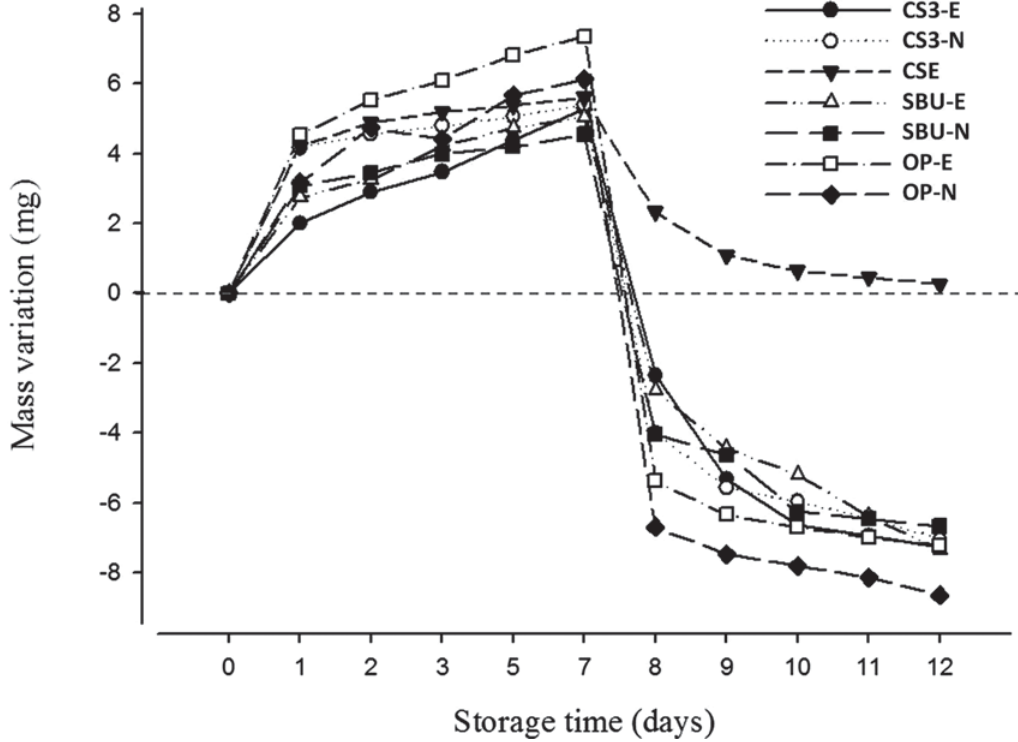
Figure 2- Changes in mass of the adhesive systems tested in the water sorption/solubility test. Symbols represent mean Y(cid:5)(cid:3)(cid:18)(cid:4)(cid:23)(cid:8)(cid:15)Z#$&(cid:16)(cid:26)(cid:8)(cid:9)(cid:25)(cid:5)(cid:13)(cid:14)(cid:5)(cid:6)(cid:14)(cid:8)(cid:14)(cid:4)Y(cid:17)(cid:5)(cid:25)(cid:17)(cid:12)(cid:13)(cid:8)Y(cid:5)(cid:3)(cid:18)(cid:4)(cid:23)(cid:8)+(cid:4)(cid:6)(cid:4)(cid:8)(cid:13)(cid:12)(cid:25)(cid:8)(cid:17)(cid:13)(cid:14)(cid:17)(cid:24)(cid:5)(cid:25)(cid:4)(cid:14)(cid:26)(cid:8)\^(cid:8)_(cid:8)\*(cid:25)(cid:17)‘(cid:12)(cid:13)(cid:14)(cid:8)(cid:9)(cid:12)(cid:3)(cid:12)(cid:8)^(cid:3)(cid:18)(cid:23)j(cid:8)(cid:2)(cid:9){(cid:8)_(cid:8)(cid:2)(cid:3)(cid:4)(cid:5)(cid:6)(cid:7)(cid:3)(cid:8)(cid:9)|(cid:8)(cid:11)(cid:12)(cid:13)(cid:14)j(cid:8)(cid:5)(cid:13)(cid:14)(cid:8)(cid:9)(cid:11)}(cid:8)_(cid:8) Scotchbond Universal Adhesive as a function of the solvent evaporation (non-evaporated - N) or evaporated solvents - E)